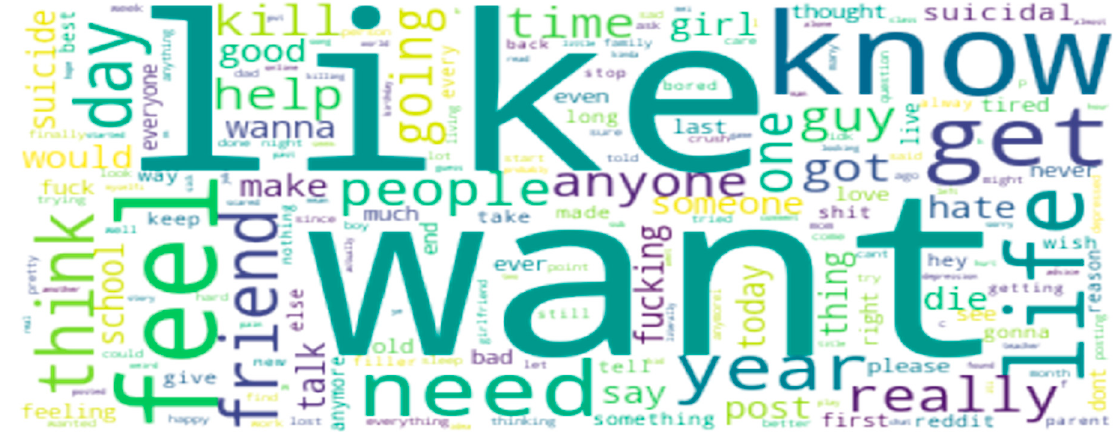
Figure 8. Word cloud based on the dataset.